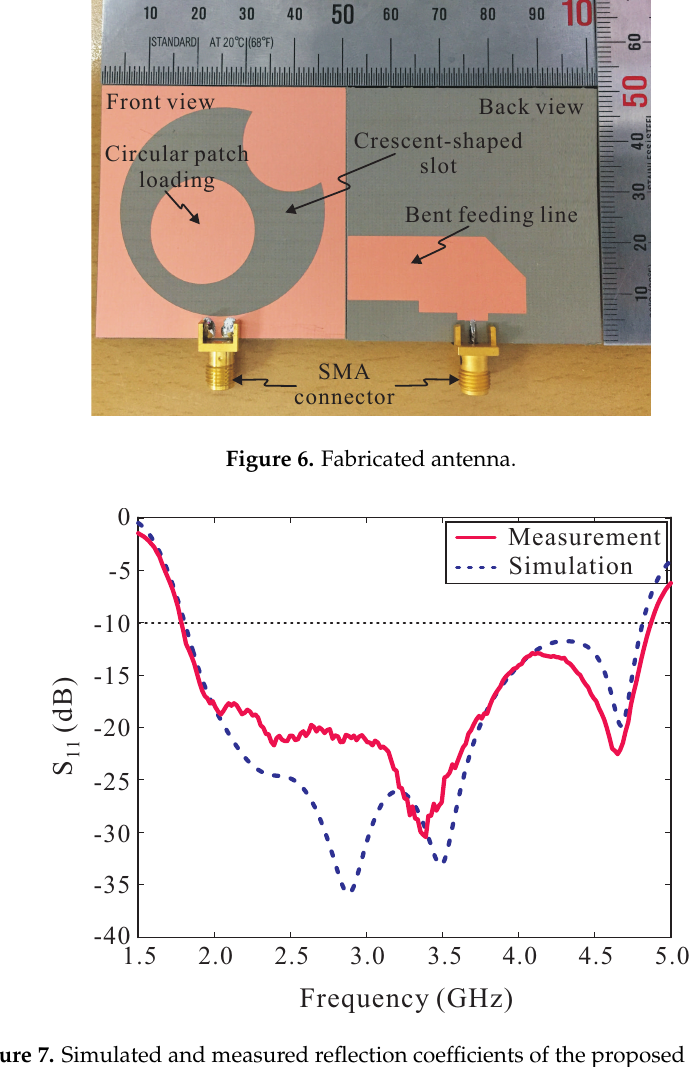
Figure 7. Simulated and measured reflection coefficients of the proposed